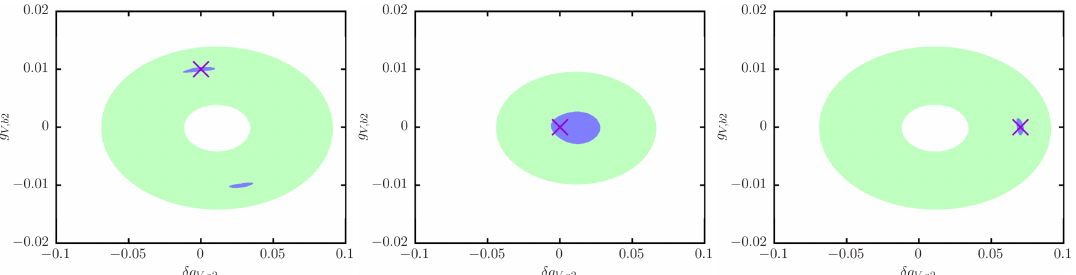
Figure 10 . The fit results with inclusive cross section (green) and differential cross section (blue) with three different assumptions on the central values: ( δg true √ with s = 100 TeV and an integrated luminosity 30 ab − 1